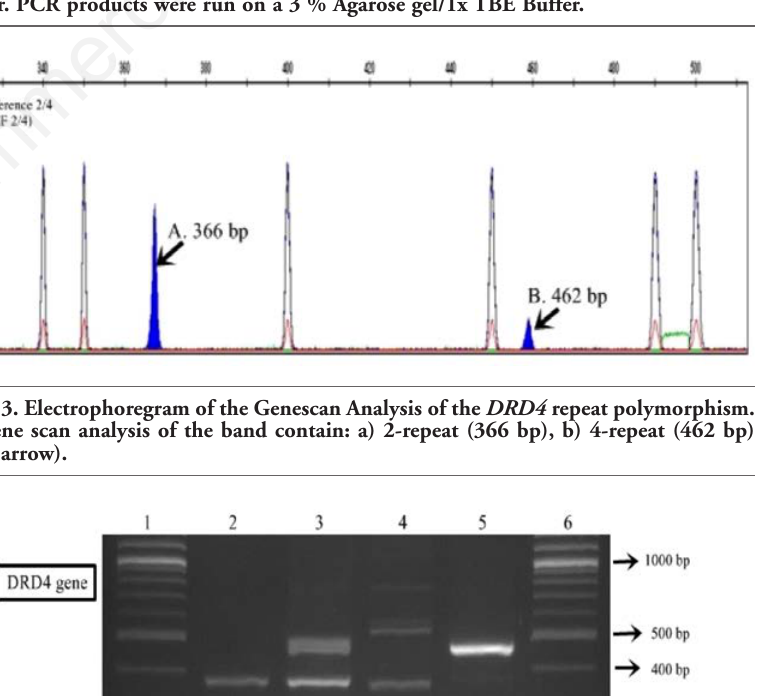
Figure 2. PCR Analysis of the DAT1 repeat polymorphism. Lane 1: DNA Marker (100 bp). Lane 2: homozygote, 9- repeat. Lane 3: heterozygote, 9- and 10- repeat (REF (9/10)). Lane 4: homozygote, 10- repeat. Lane 5: heterozygote, 10- and 11- repeat. Lane 6: DNA Marker. PCR products were run on a 3 % Agarose gel/1x TBE Buffer.